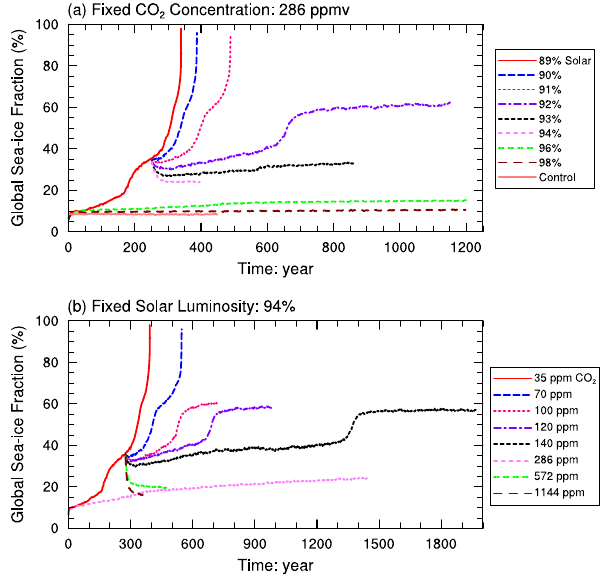
Fig. 5. Sea ice evolution in two groups: fixed CO 2 concentration (286ppmv) but with different solar constants (a) , and fixed the so- lar constant (94% of the present-day level) but with different CO 2 levels (b) . In (a) , the experiments with 90–94% solar radiation are initiated from the 251th year of the case with 89% solar radiation; in (b) , the experiments with 70–120 and 572–1144ppmv CO 2 are initiated from the 276th year of the case with 35ppmv CO 2 ; other experiments are initiated from the present-day climate.